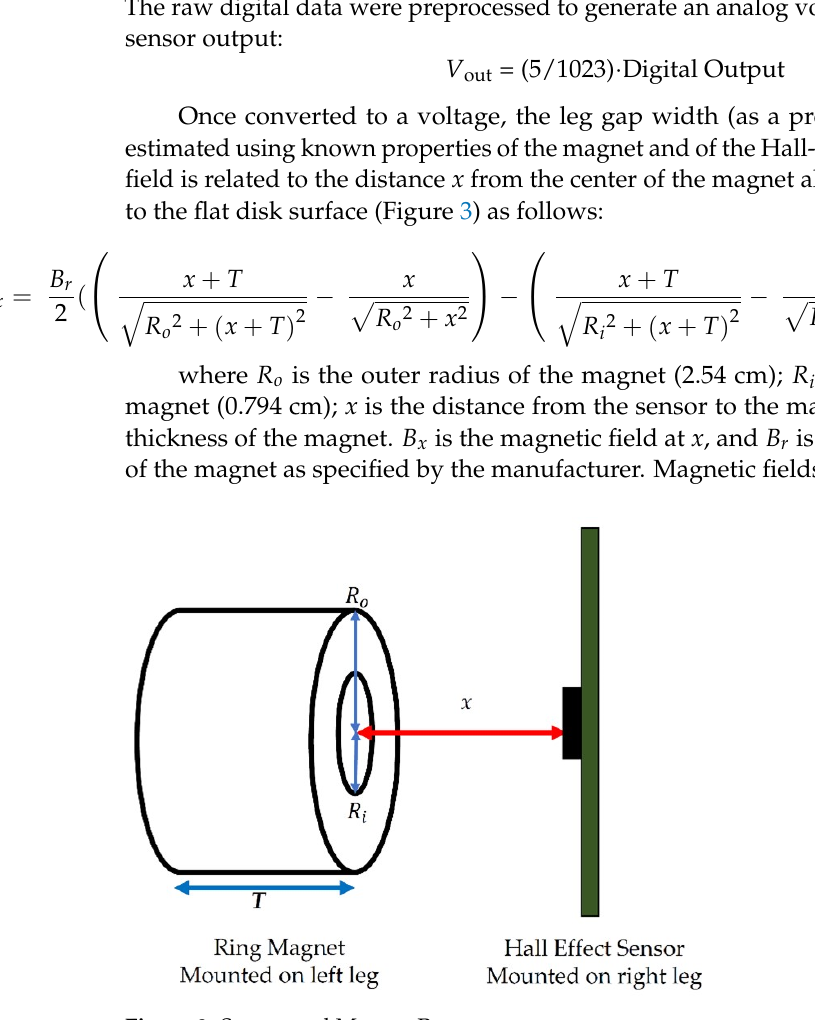
Figure 3. Sensor and Magnet Parameters.